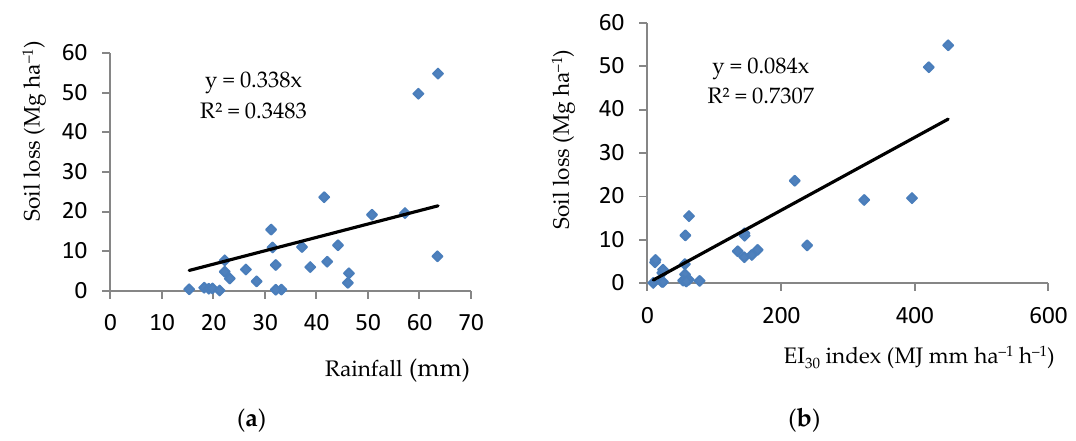
Figure 5. Soil loss through surface runoff per unit area depending on the rainfall amount ( a ) and index EI 30 ( b ).